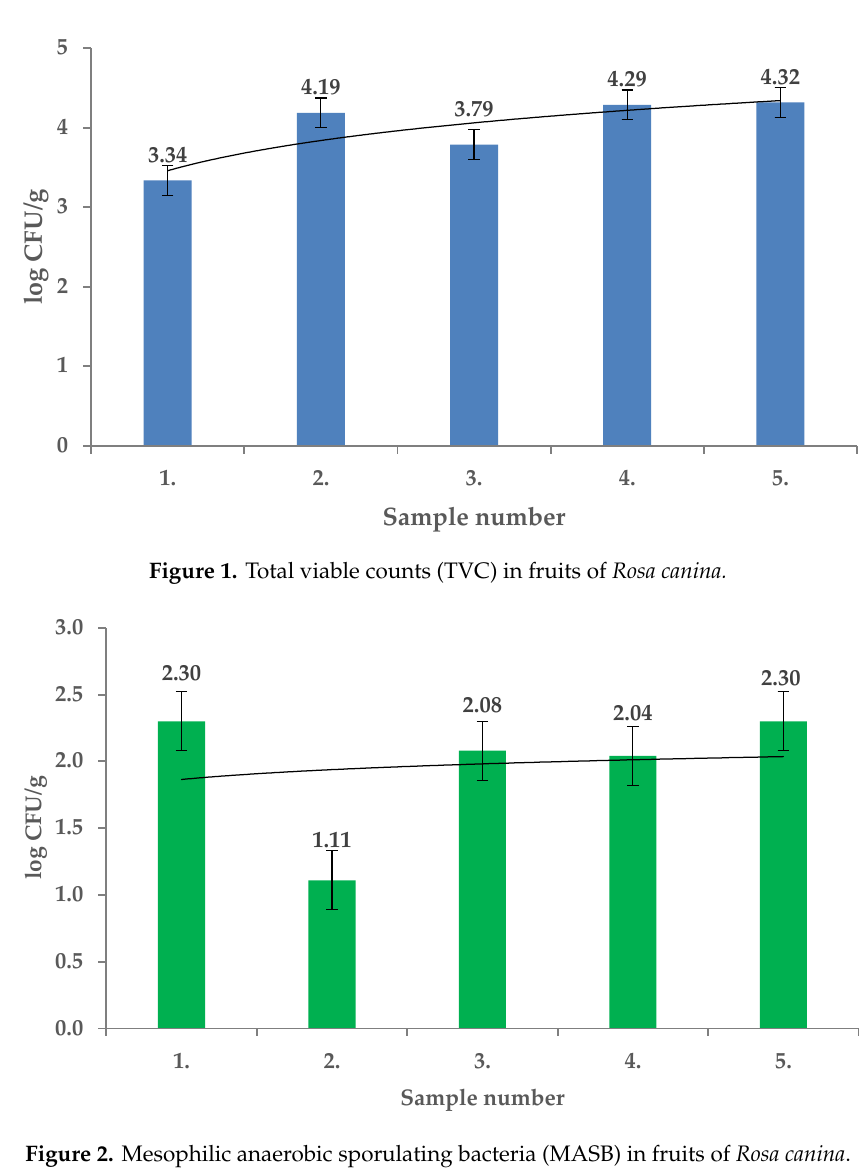
Figure 2. Mesophilic anaerobic sporulating bacteria (MASB) in fruits of Rosa canina .